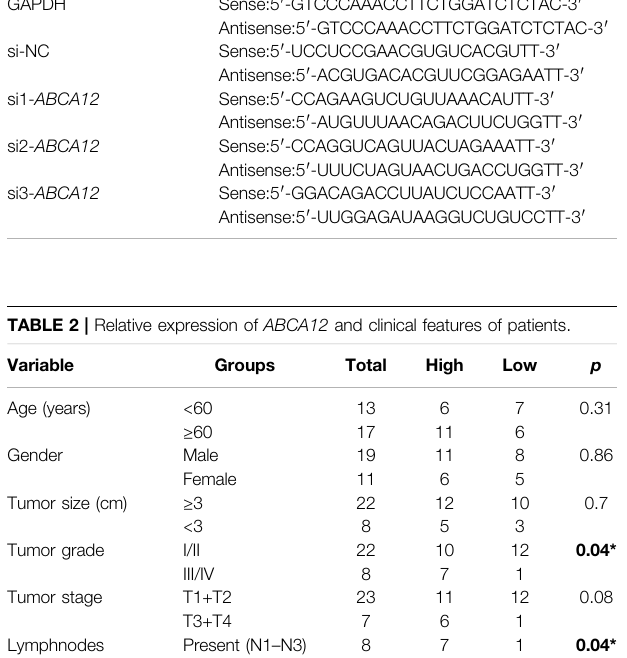
25 min and then incubated with streptavidin-peroxidase for another 25 min. Rinse with PBS and DAB staining solution (DAB-0031; Fuzhou Mai Xin) staining sections, distilled water stopped color, and hematoxylin restained the nuclei. After the neutral gum sealing cover slides, the microscope was used for observation, and random photos were taken.